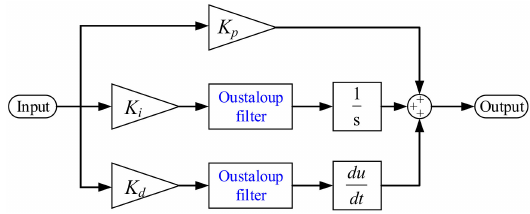
Figure 2. Structure of the FOPID